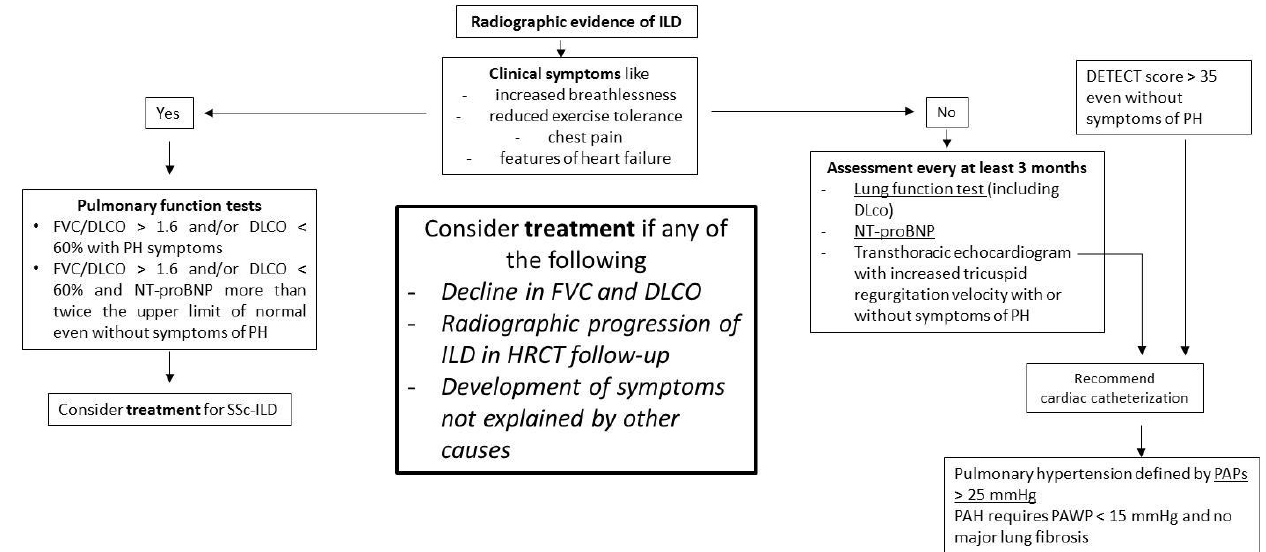
Figure 1. Practical algorithm about the use of HRCT/PFT in SSc ILD.